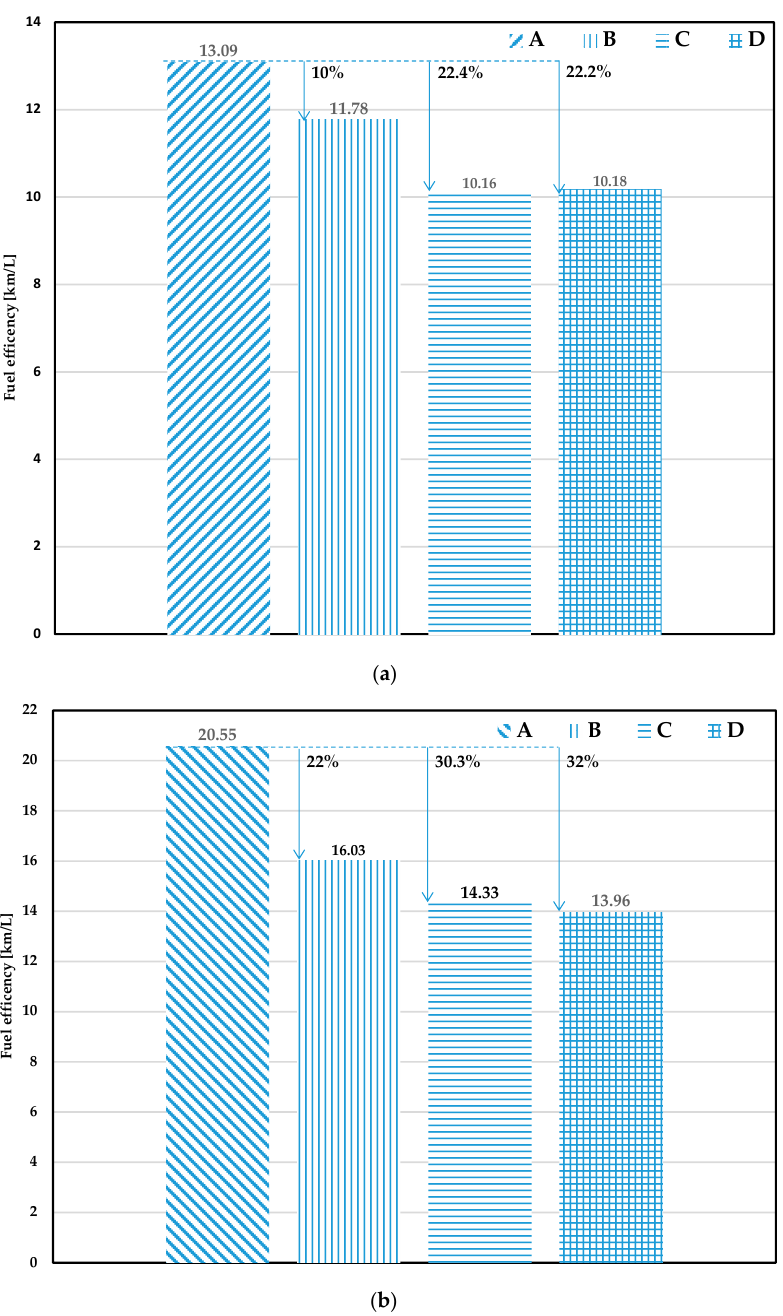
Figure 5. Comparison of fuel efficiency calculated from Equation A, B, C, and D. ( a ) City mode ( b ) Highway mode.